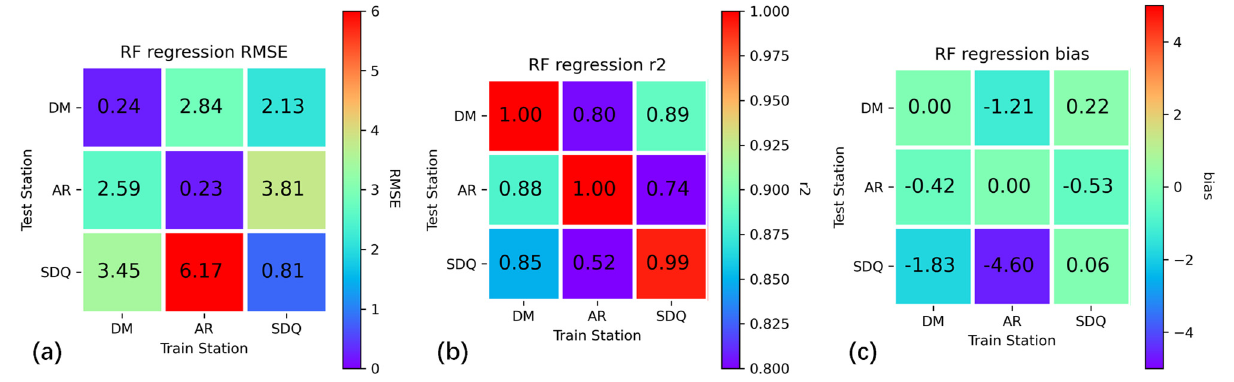
Figure 9. The RMSEs of predicted results by RF regression method using training and test data from cross stations during different years. (a–c) correspond to RMSE, R 2 , and bias, respectively.